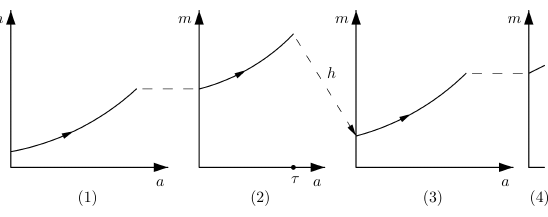
Fig. 3. Evolution of maturity of a mother cell: (1) – resting phase; (2) – proliferating phase and a daughter cell: (3) – resting phase; (4) – proliferating